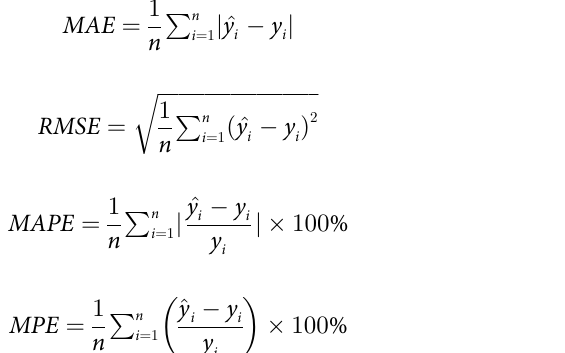
ffiffiffiffiffiffiffiffiffiffiffiffiffiffiffiffiffiffiffiffiffiffiffiffiffiffiffiffiffiffiffi 1